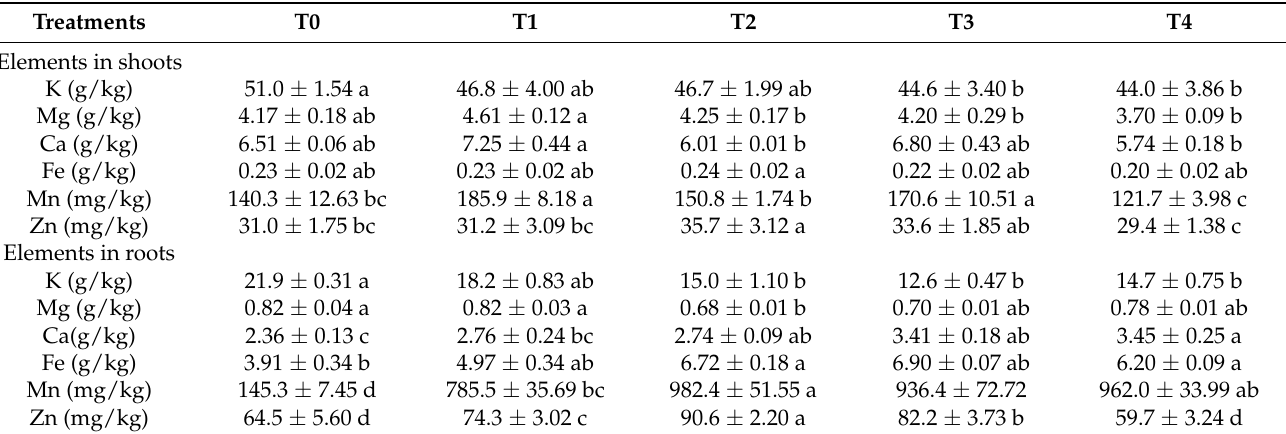
Table 2. Effects of chlorinated amino acetic acid on mineral elements in Z35 rice